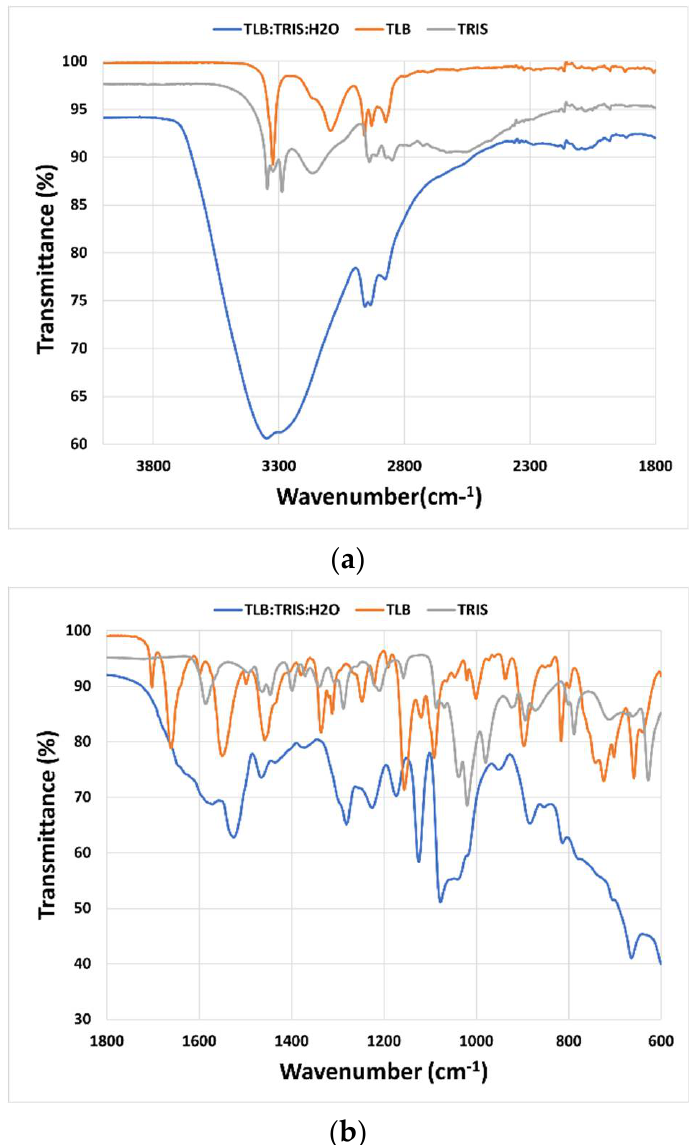
Figure 5. Mid infrared spectra from the TLB-THELES, pure crystalline TLB, and pure crystalline TRIS. ( a ) Spectral region between 4000 cm − 1 and 1800 cm − 1 ; ( b ) spectral region between 1800 cm − 1 and 600 cm − 1